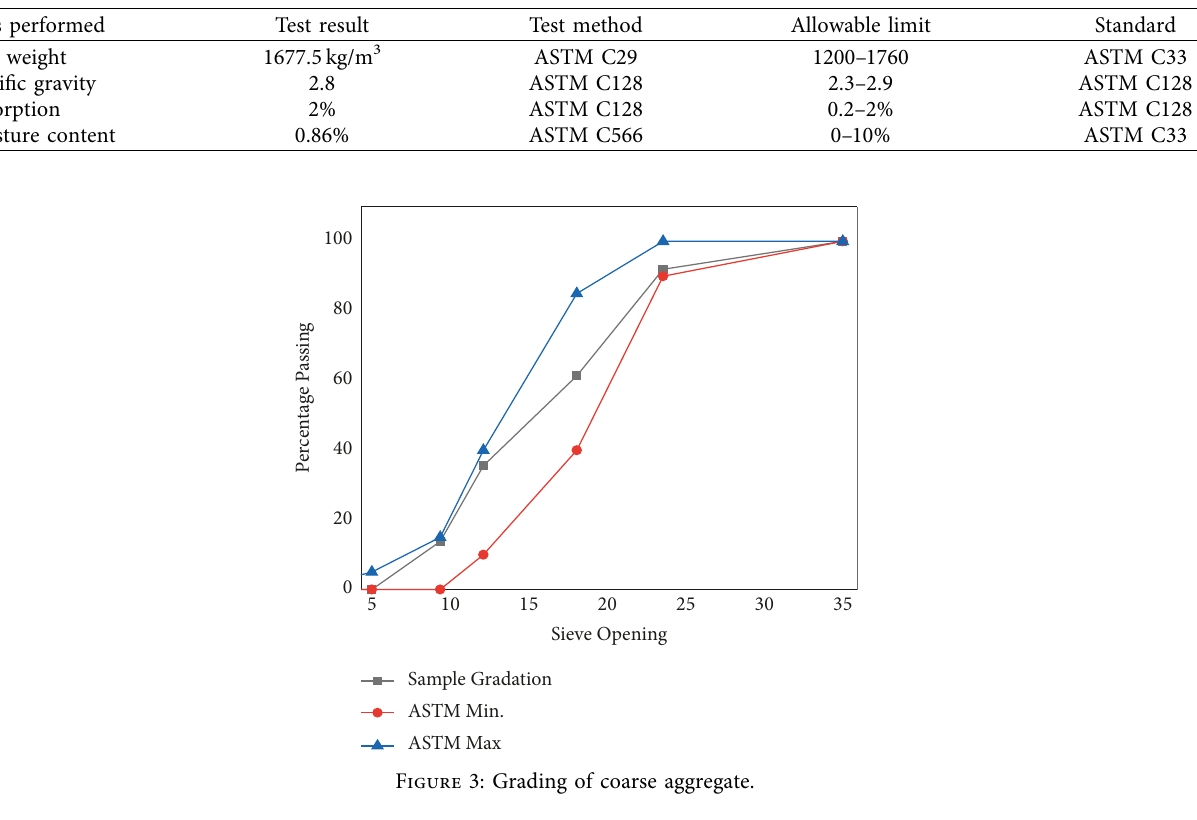
Table 3: Properties of coarse